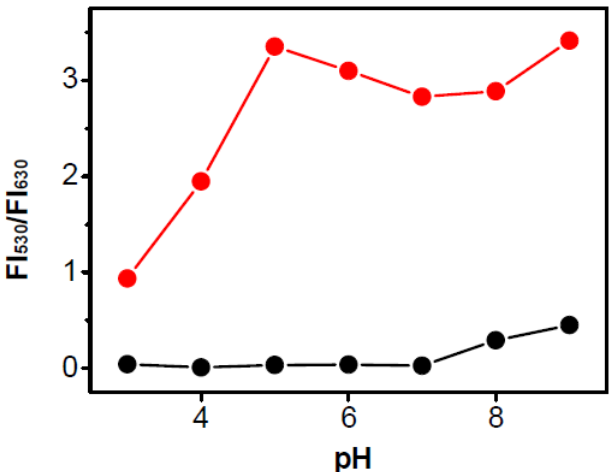
Figure 3. The pH effect on the fluorescence response of probe 1 (10 µ M) with (red) and without (black) NTR (2 µ g/mL) and NADH (300 µ M). All data were obtained in pH buffer containing 10% of DMSO with 90 min incubation at 37 ◦ C. λ ex = 470